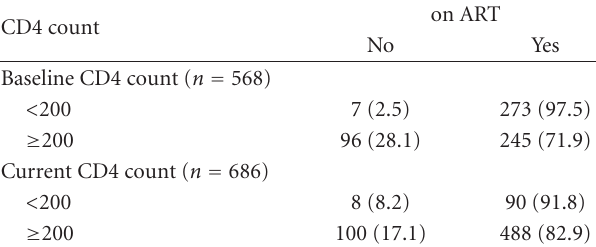
Table 2: CD4 and ART characteristics of HIV+ women screened for cervical cancer in Nazareth